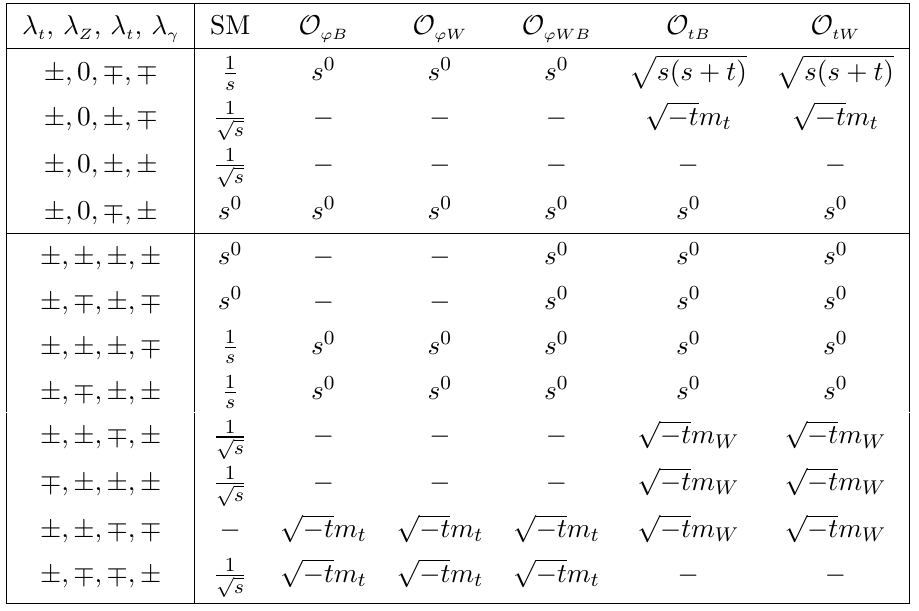
Table 15. Helicity amplitudes in the high-energy limit ( s Overall multiplicative factors are dropped and only the schematic energy dependence is retained for the SM contribution. Helicity entries marked by ‘ section 5.1.4 for a discussion of the results.